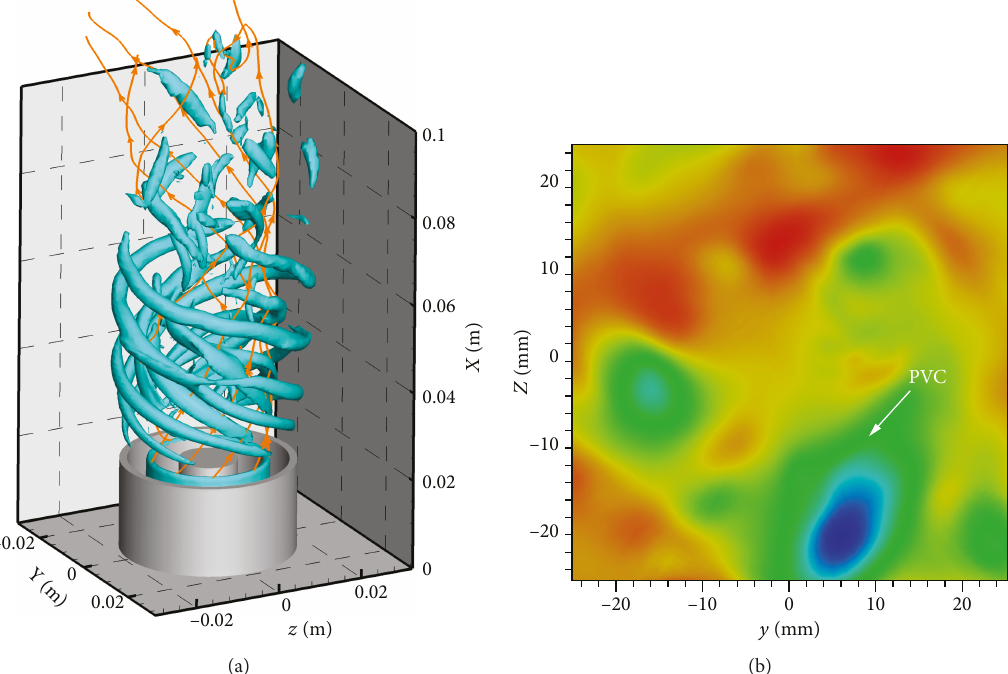
Figure 13: Instantaneous vortex structures (a) and PVC (b) for the nonreacting